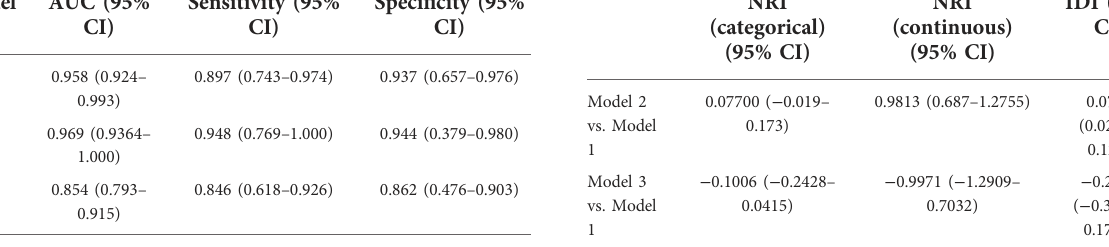
TABLE 7 AUC, sensitivity, and speci fi city of three models. Model